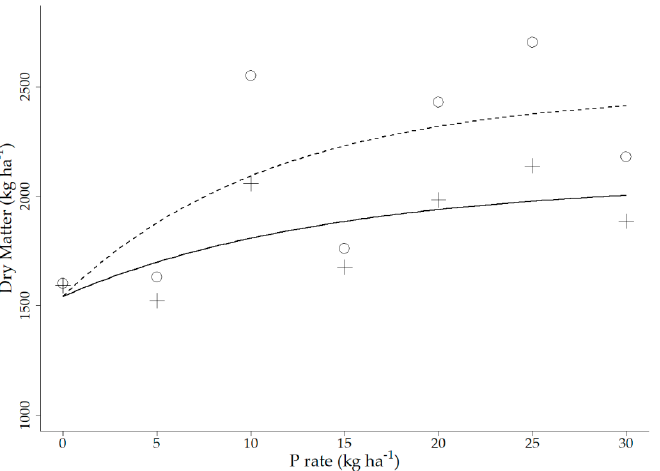
Figure 1. Lanza ® tedera shoot biomass response (kg dry matter ha − 1 ) to P application over two growing seasons (cumulative biomass above 5 cm from July and October cuts) at Dandaragan: 2018 data are open circles and dotted line, and 2019 data are crosses and solid line. Fitted models are Mitscherlich functions (2018 DM = 2479 – 934e − 0.09x ; 2019 DM = 2069 – 525e − 0.07x ).